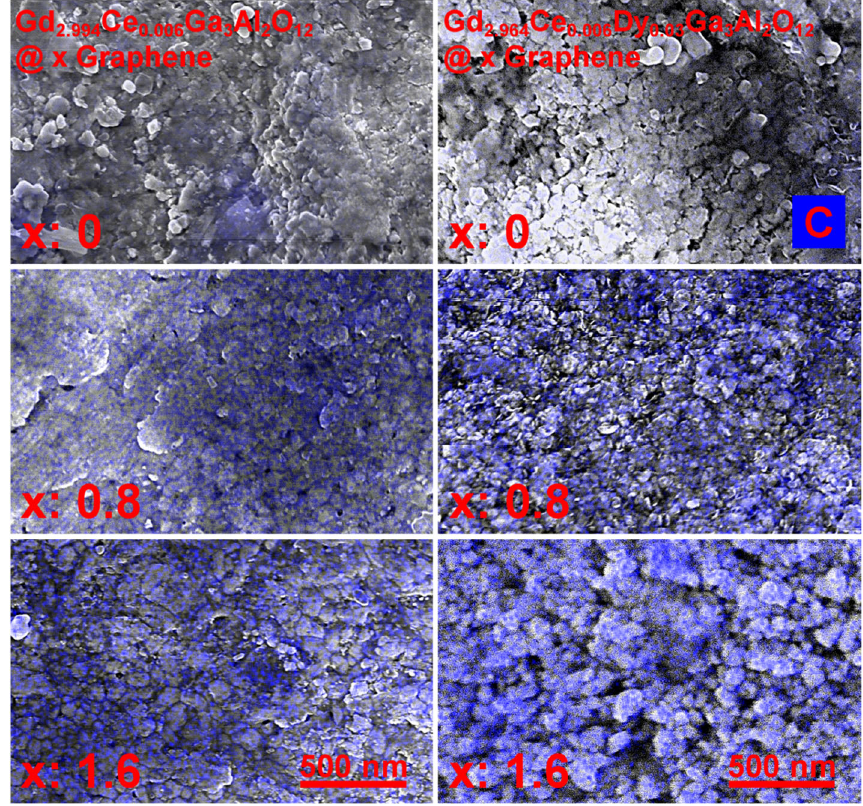
Figure 3. SEM + EDS maps indicating carbon (C) amount in the Gd 2.994 Ce 0.006 Ga 3 Al 2 O 12